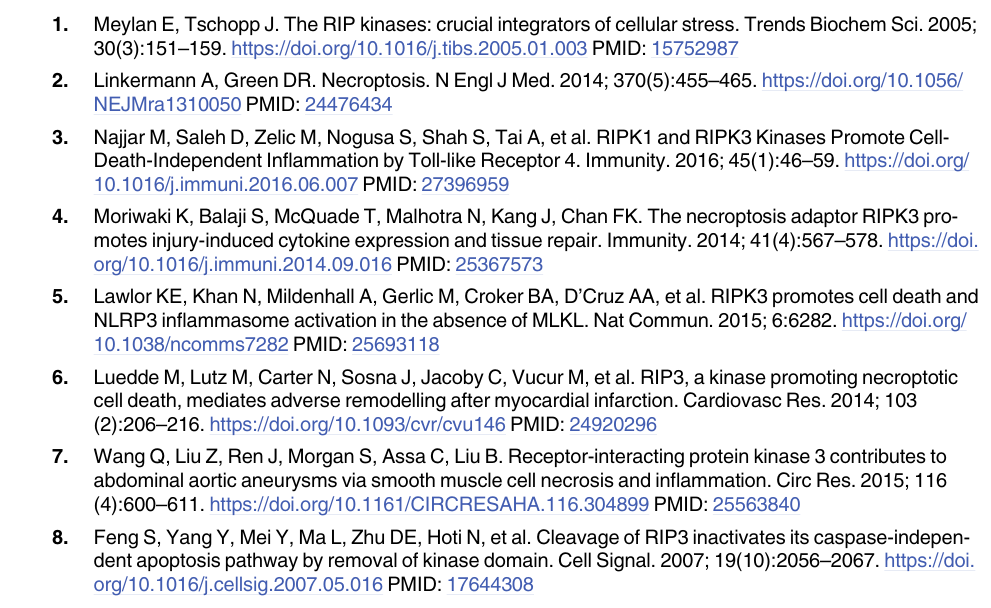
S9 Table. (related to Materials and Methods). Plasmids used in this